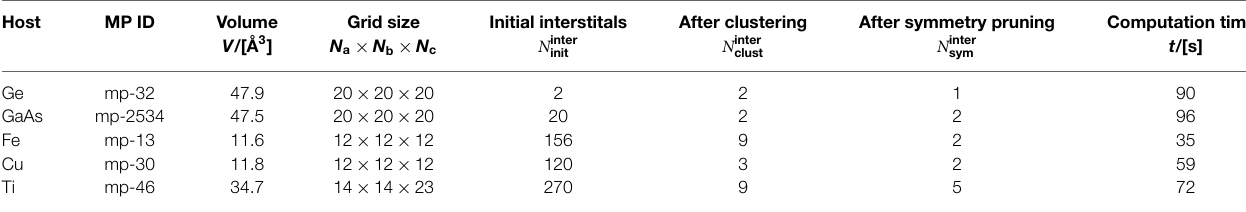
TABLE 3 | Interstitials found in primitive unit cells.